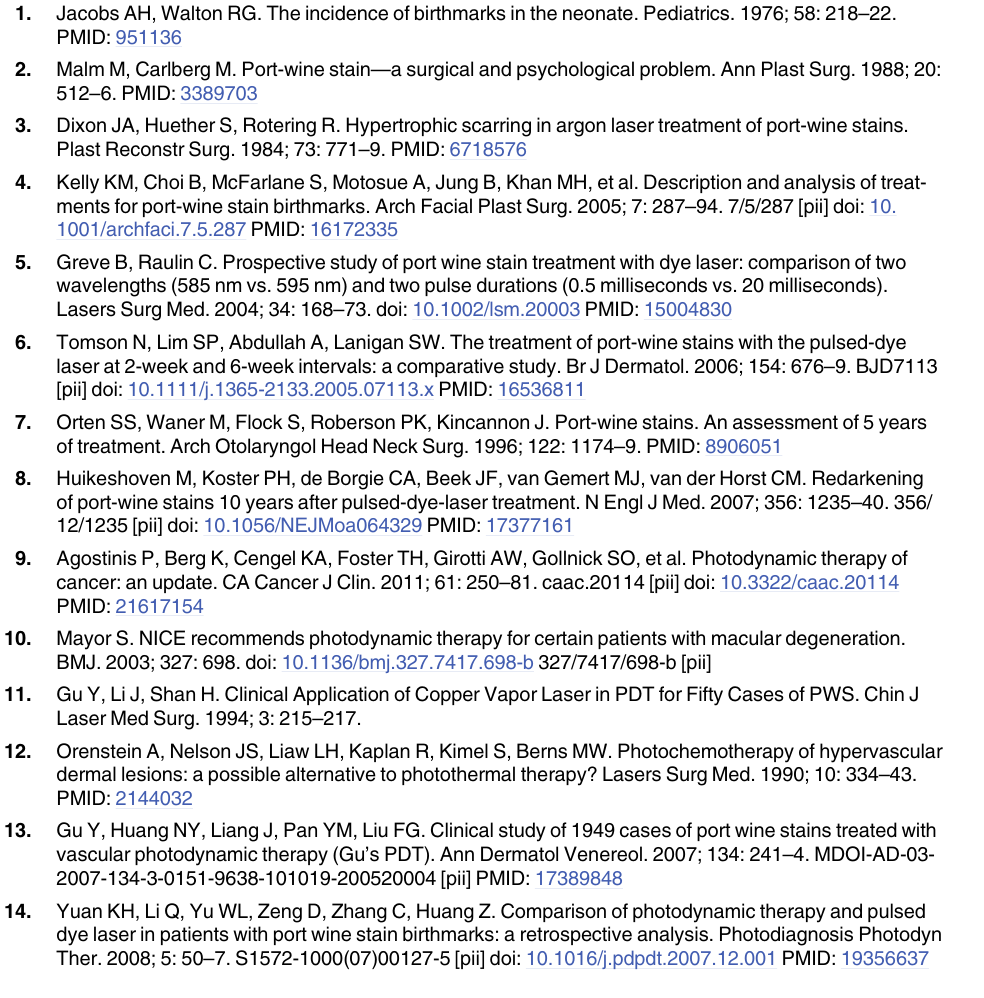
S2 Table. Stratified analysis of efficacy at week 8 for the patients who received hemoporfin in stage 1. S3 Table. Stratified analysis of efficacy based on PWS type at week